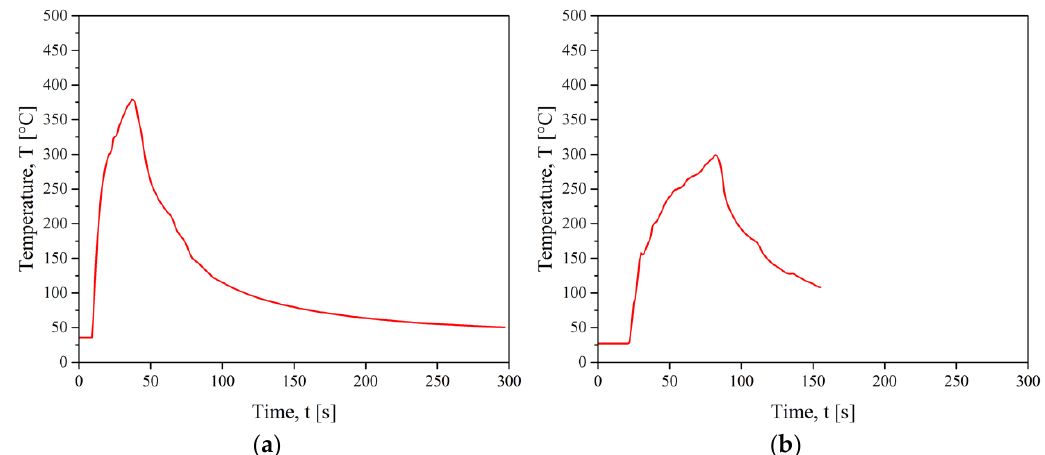
Figure 11. Temperature monitoring during IW for ( a ) CF/PEEK on CF/PEEK and ( b ) PEI 1 mm on CF/PEEK.